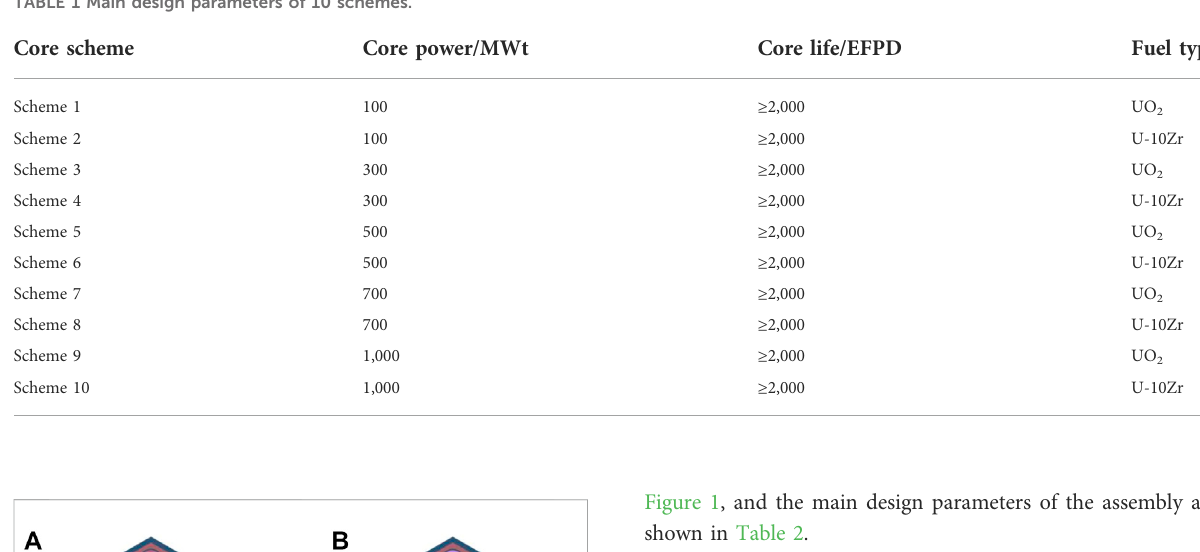
Figure 1, and the main design parameters of the assembly are shown in Table 2.